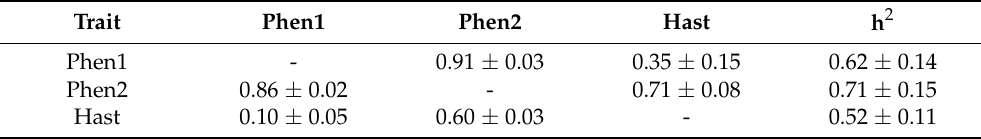
Table 7. Estimates of parameters ( ± standard error) obtained from the bivariate analyses. Additive genetic correlation estimates above the diagonals and phenotypic correlations below the diagonals.